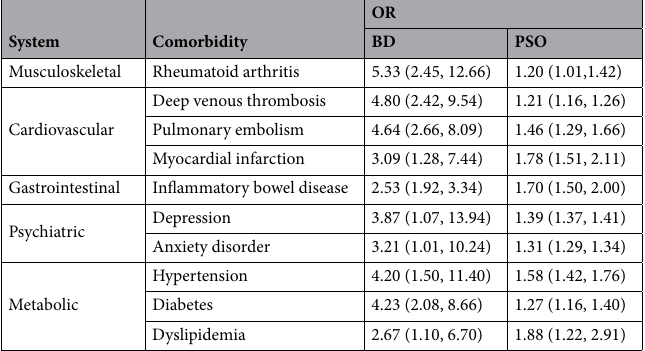
Table 1. Comorbidities that are most frequently shared by BD and PSO. OR, odds ratio (95% confidence intervals); BD, Behçet disease; PSO,